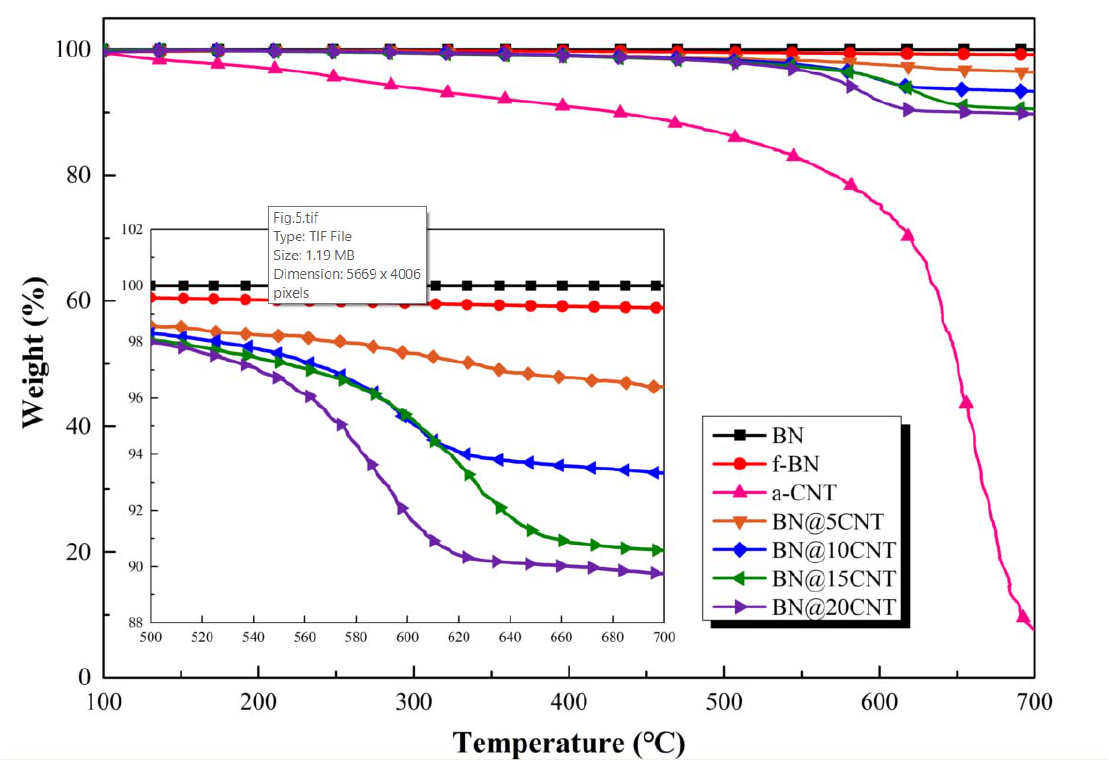
Figure 5. TGA curves of h ‐ BN, f ‐ BN, BN@xCNT and a ‐ CNT. Table 2. Calculated results of content of CNTs and corresponding data used.